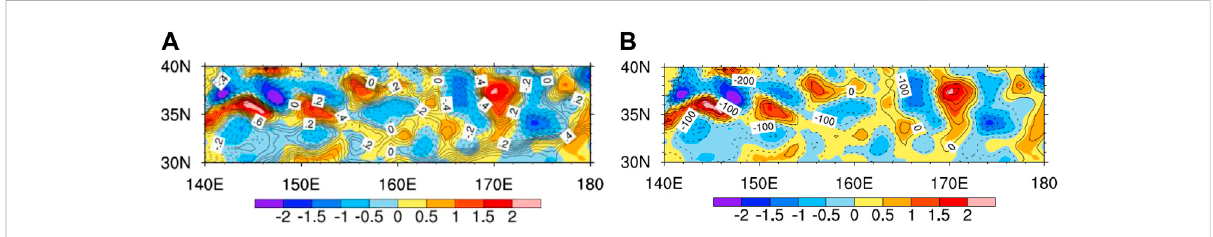
Boundary-layer response to KE-related SSTAs in the cold season (KSTS-MEFS). (A) KE-related mesoscale SSTAs ( ° C, shading) and 10 m wind speed (m s − 1 , contours); (B) KE-related mesoscale SSTAs ( ° C, shading) and boundary-layer thickness anomalies (m, contours).